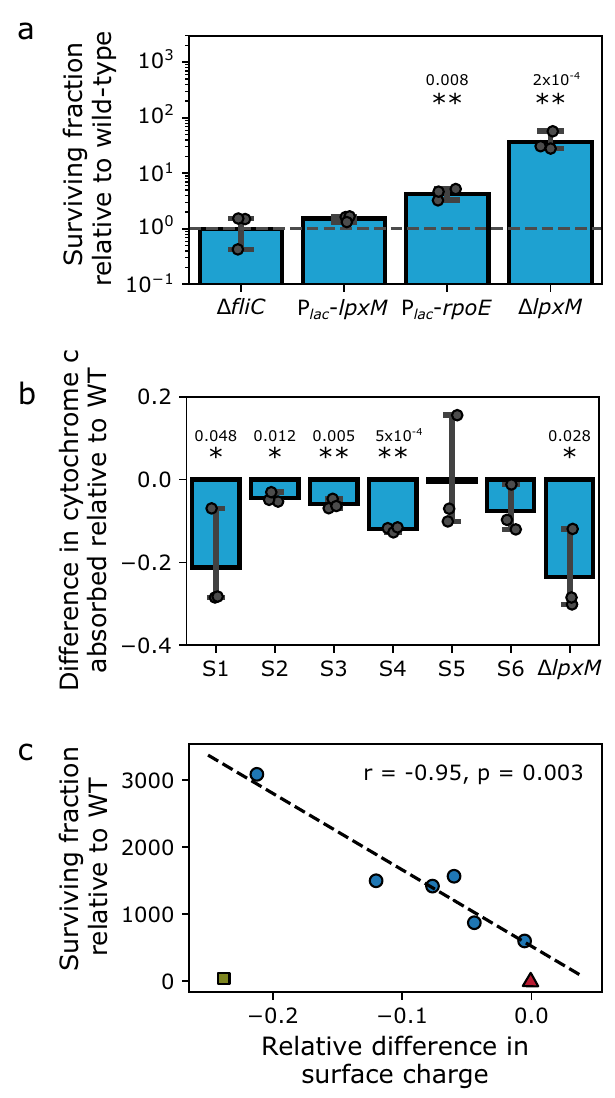
Fig. 4 Evolved tolerance against benzalkonium chloride is related to membrane surface charge, motility, and bio fi lm formation. a Mutants of outer membrane biogenesis and envelope stress, but not fl agella, show increased levels of survival against BAC. Survival fractions were scaled to the survival fraction of the corresponding wild-type. Bars represent the geometric mean ± 95% C.I., n = 4 biological replicates. Δ indicates knock- out mutants; P lac , P BAD indicate inducible promoter; for strain details, refer to Table S3. Signi fi cance of difference to wild-type is indicated by asterisks: (cid:1) p < 0.05; (cid:1)(cid:1) p < 0.01 (two-tailed t-test of log-transformed survival fraction. b The evolved clones and a knock-out of lpxM absorb signi fi cantly less positively charged cytochrome c than the ancestor, indicating a reduction in net-negative surface charge caused by mutations in lpxM . Shown is the mean ± 95% C.I., n = 3 biological replicates. Signi fi cance of decreased cytochrome c absorption against ancestor is indicated by asterisks: (cid:1) p < 0.05; (cid:1)(cid:1) p < 0.01 (one-tailed one-sample t-test for difference from 0). c Quantitative relationship between tolerance against BAC and changes in surface charge in the evolved clones (circles). The wild-type is shown as triangle, the lpxM knock-out is shown as square. The Pearson correlation coef fi cient r for the evolved clones is indicated in the plot and was calculated with the data from the evolved clones only. Signi fi cance of correlation: two-sided test with t-distribution of the test statistic. Source data are provided as a Source Data fi le. Exact p -values are indicated above the